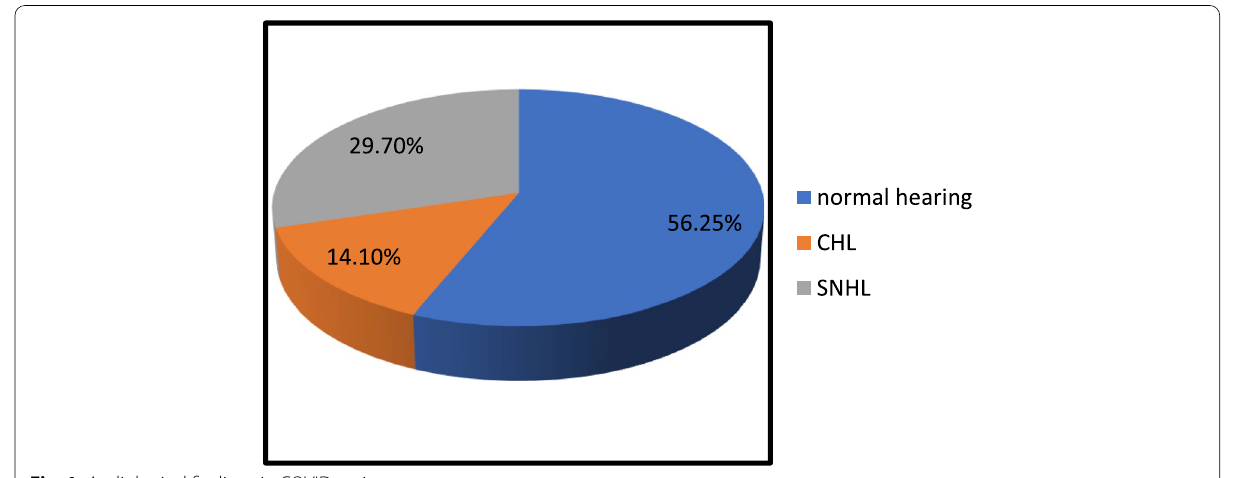
Fig. 1 Audiological findings in COVID